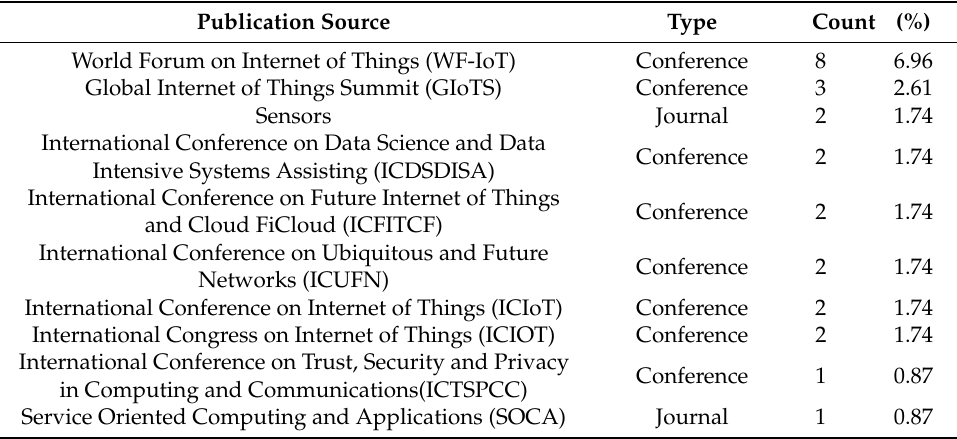
Table A1. Publication Source Wise Distribution of